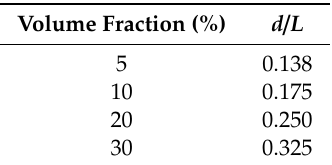
Figure 3. Gyroid TPMS unit cell with minimum thickness d and cell size L . Table 2. Design data of multiple gyroid TPMS lattices.